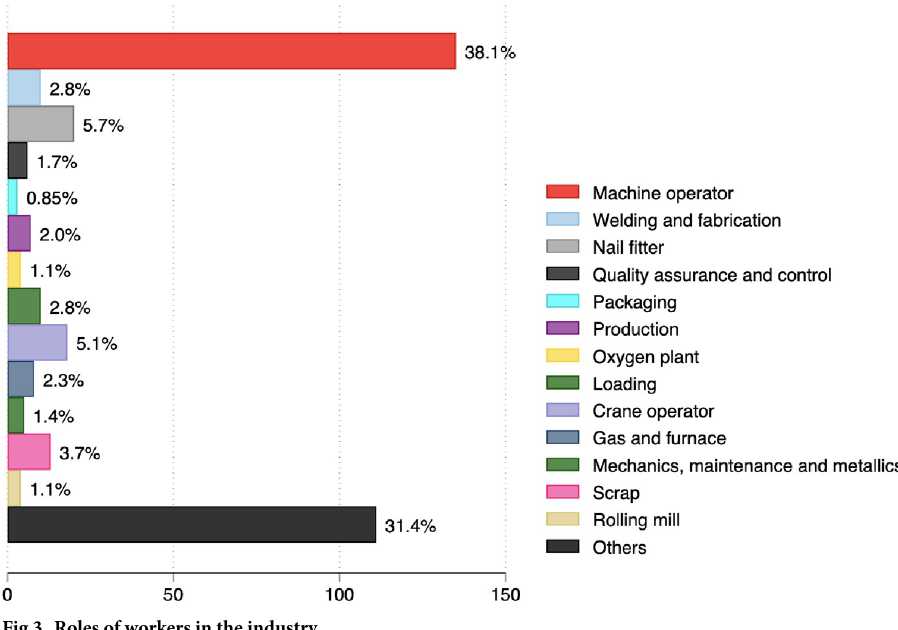
Fig 3. Roles of workers in the